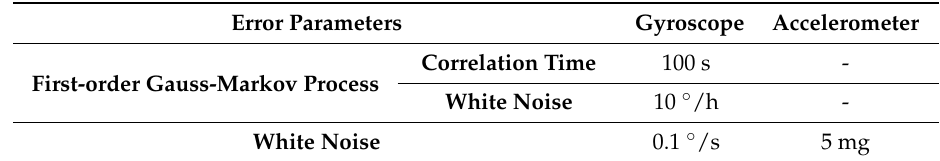
Table 1. MEMS gyroscope and accelerometer error parameters for the digital simulation.